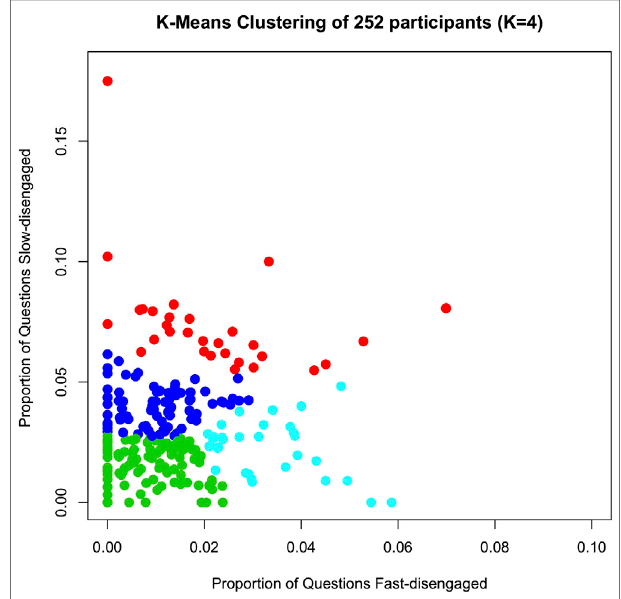
FIGURE 2 | K-mean clustering of 252 participants on the proportion of fast- and slow-disengagement rate. Red dots: students with a medium-to- high proportion of fast-disengaged question-answer observations and high proportion of slow-disengaged question-answer observations ( HiFast/ HiSlow ); Deep blue dots: students with a small proportion of fast-disengaged question-answer observations and medium-to-high proportion of slow- disengaged question-answer observations ( LowFast/HiSlow ); Aqua blue dots: students with a high proportion of fast-disengaged question-answer observations and small proportion of slow-disengaged question-answer observations ( HiFast/LowSlow ); Green dots: students with a small proportion of fast-disengaged question-answer observations and small proportion of slow-disengaged question-answer observations ( Engaged ).